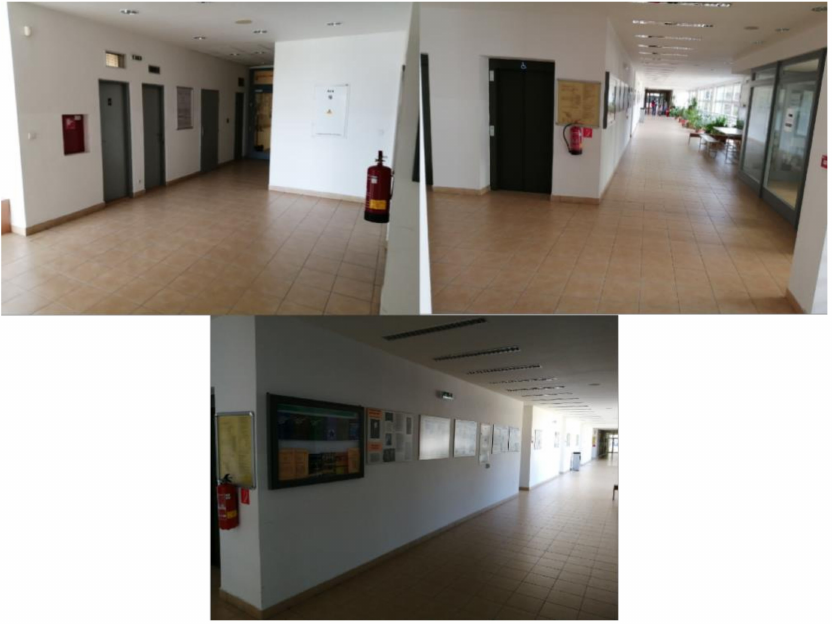
Figure 7. Corridors in the department.